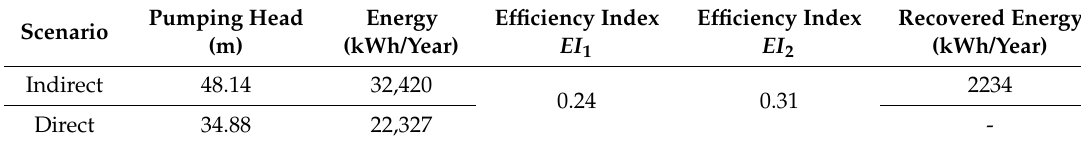
Table 1. Main figures of the indirect and direct pumping